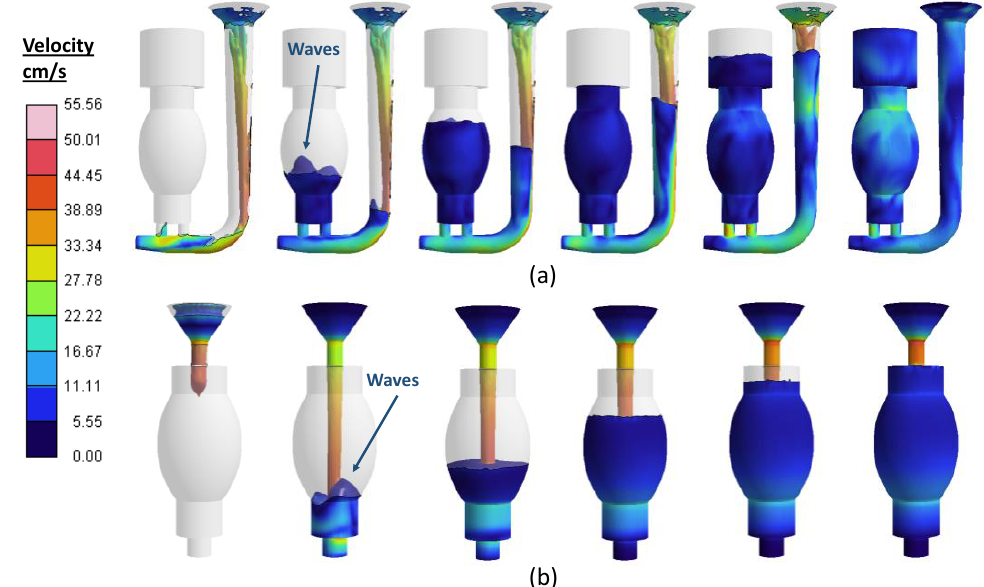
Figure 7. ( a ) Velocity profile for BJ gravity-pouring, ( b ) velocity profile for BJ vacuum-assisted oxide films.